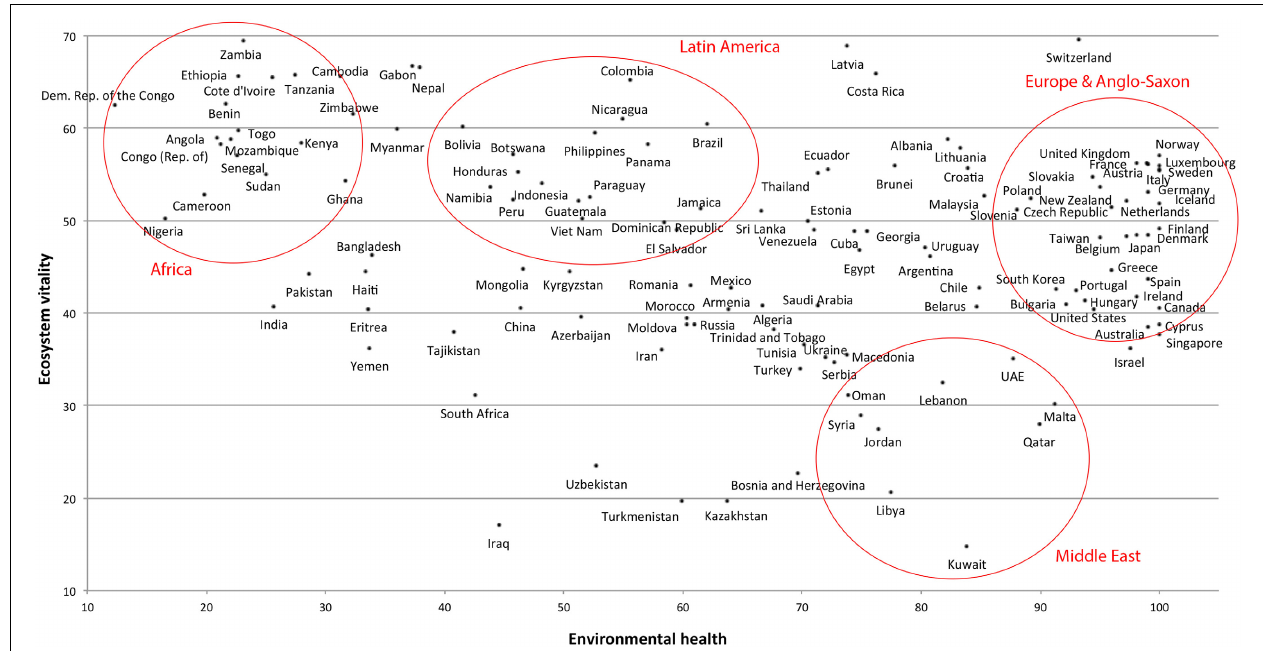
FIGURE 1 | A scatterplot of Environmental Health and Ecosystem Vitality shows that the scores are clustered by geographical region (circles indicate a high concentration of countries from a particular region).